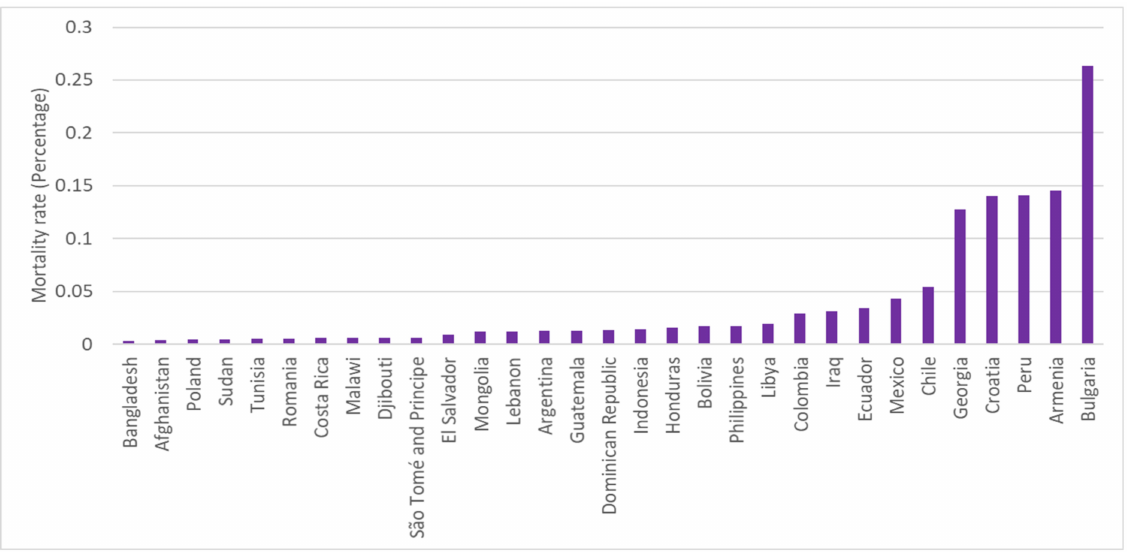
Figure 4. A total of 31 countries’ mortality rates of the COVID-19 epidemic that were higher than the median of the whole sample.